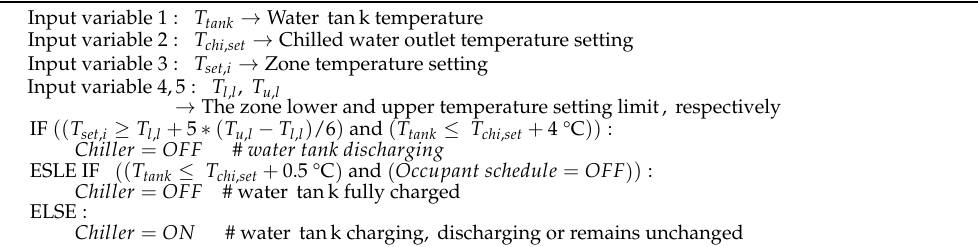
Table 3. Water tank control strategy.